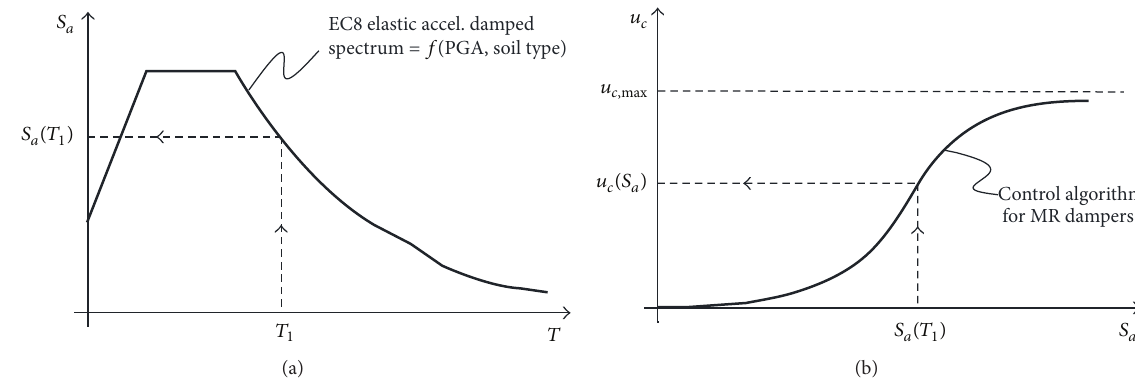
Figure 1: Code-based spectral accelerations derived by the forecasted PGA (a). Schematic shape of the smart passive control algorithm